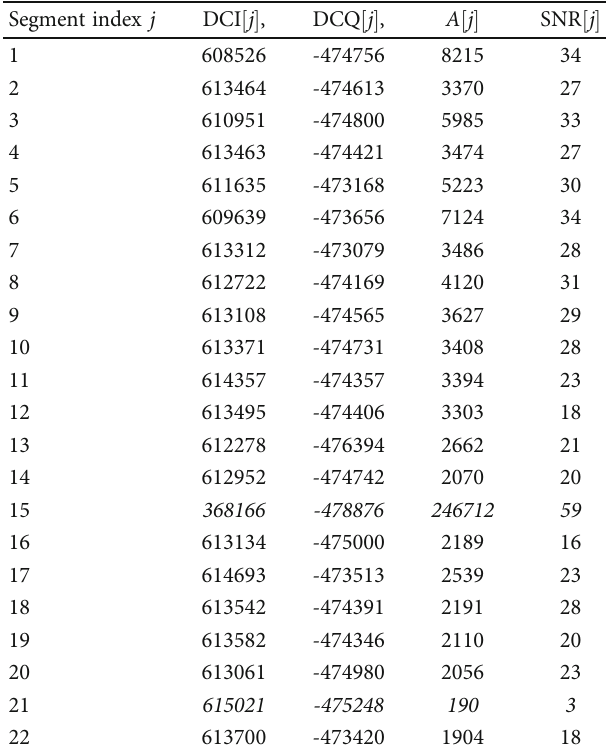
Table 1: Main parameters of each segment in the experiment of heartbeat detection with interference.